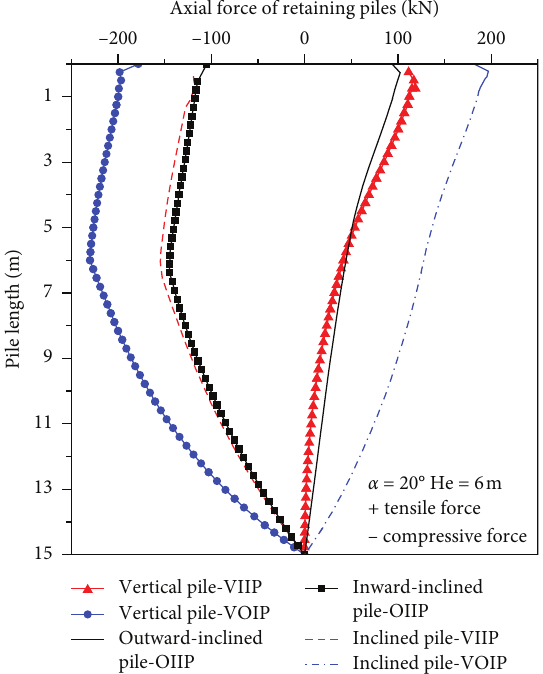
Figure 14: Axial forces of retaining piles in CIRSs.